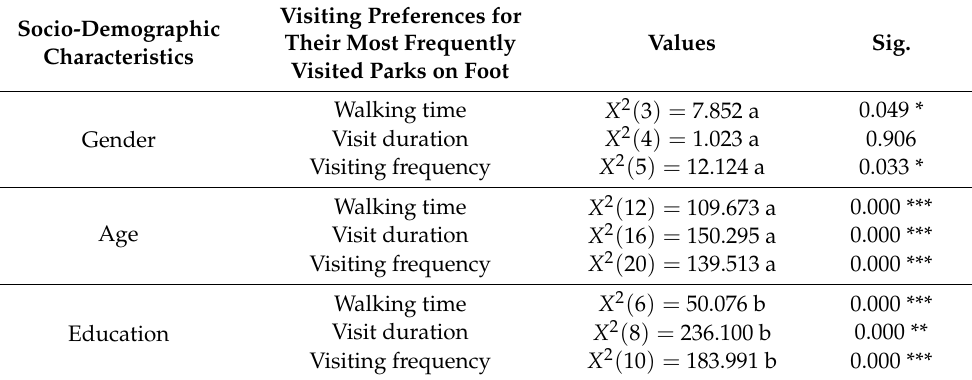
Table 3. Differences in effects of socio-demographic characteristics on visiting preferences.